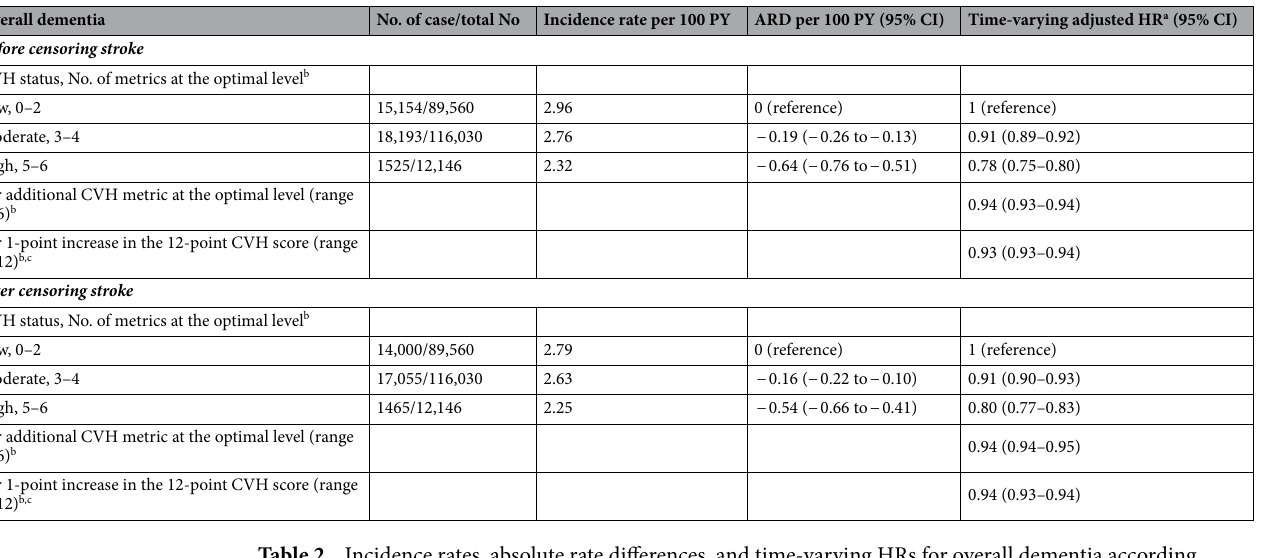
Table 2. Incidence rates, absolute rate differences, and time-varying HRs for overall dementia according to CVH Status and increasing number of optimal CVH metrics and CVH scores. a HRs with 95% CIs were estimated by time-varying Cox proportional hazard models over a median follow-up of 6.2 years (after censoring stroke, 6.1 years) for overall dementia. HRs were adjusted for age, sex, economic status, living area, comorbidities (AF, HF, MI, coronary heart disease, PAD, anemia, CKD, hyperthyroidism, hypothyroidism, osteoporosis, sleep apnea, COPD, chronic liver disease, and cancer), medications (oral anticoagulants, antiplatelet agents), depressive mood, lower extremity function, and cognitive function at baseline. b CVH status, per additional CVH metric at the optimal level and per 1-point increase in the 12-point CVH score, were used as time-varying variables. c The continuous 12-point CVH score (range, higher score indicating higher CVH) was calculated by assigning 0 (poor), 1 (intermediate), and 2 (optimal) points to each of the six metrics and summing them. AF atrial fibrillation, ARD absolute rate difference, CI confidence interval, CKD chronic kidney disease, COPD chronic obstructive pulmonary disease, CVH cardiovascular health, HF heart failure, HR hazard ratio, MI myocardial infarction, PAD peripheral artery disease, PY